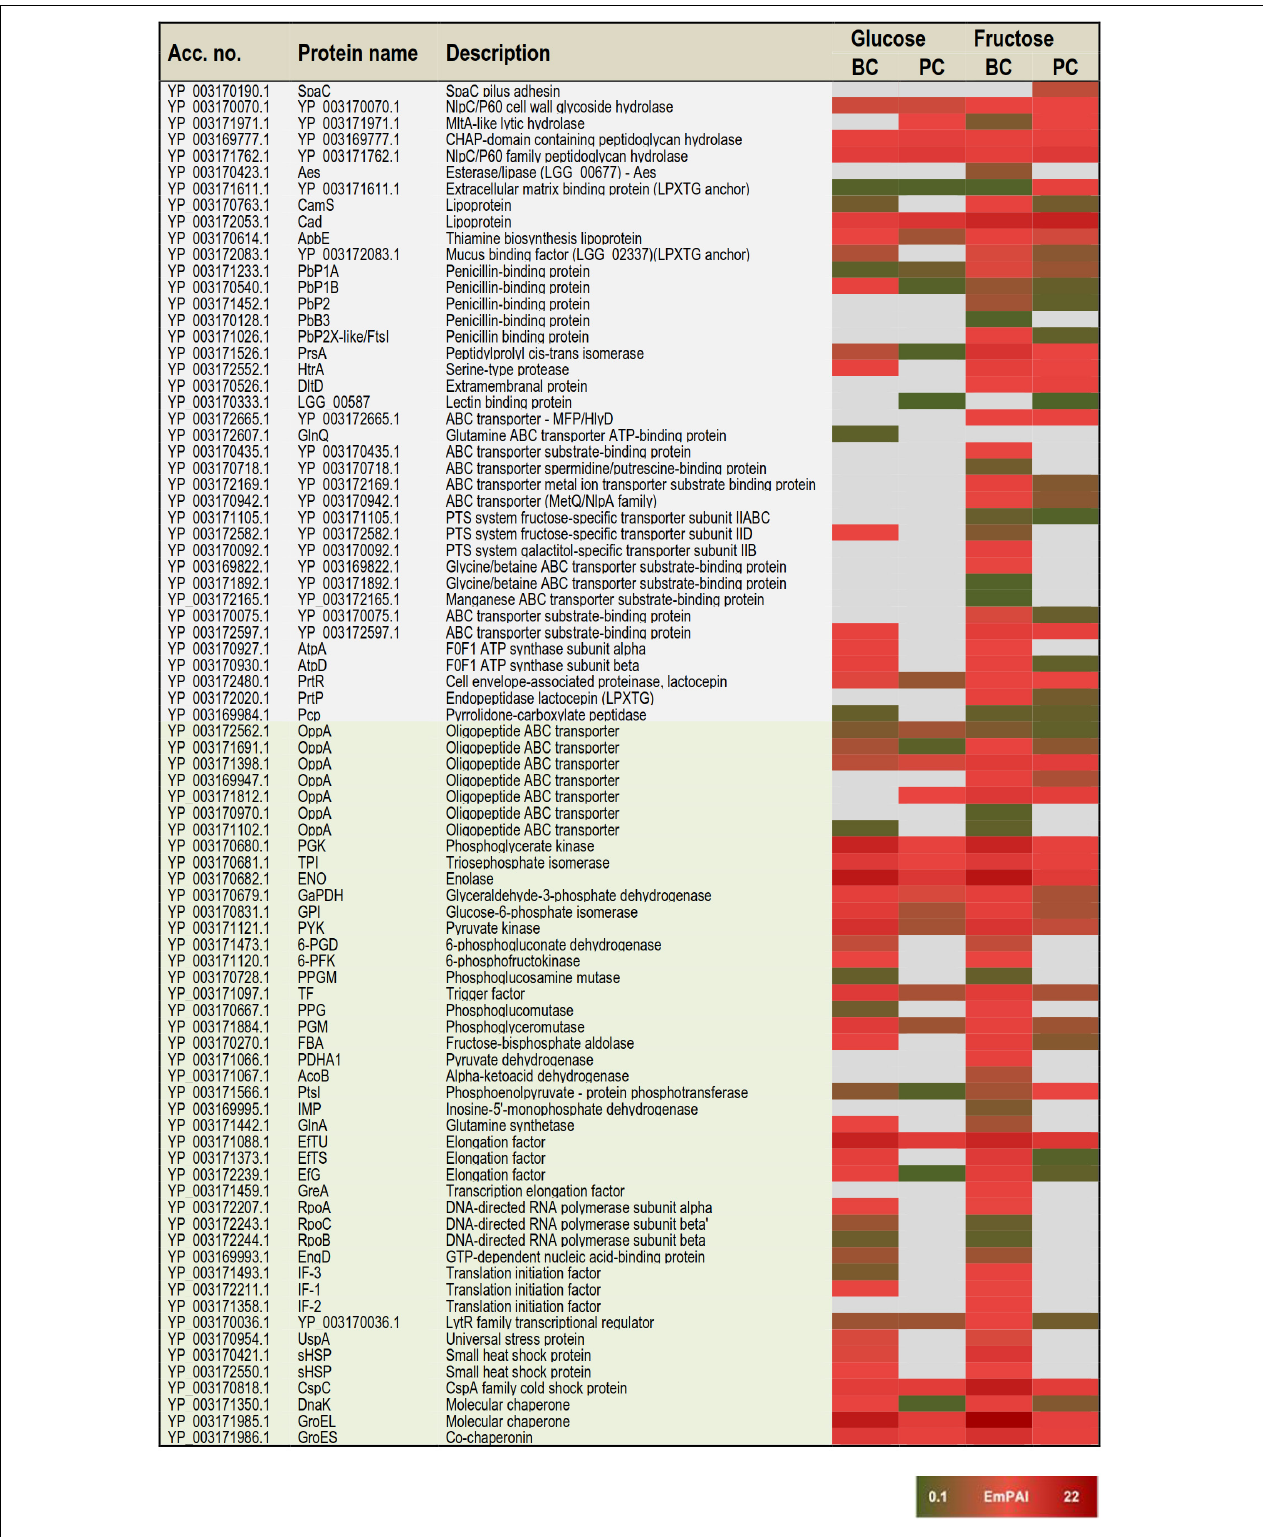
FIGURE 3 | A heat map comparing the most distinctive protein abundance changes (estimated by the emPAI values) among the classical surface proteins anchored to cell-wall/-membrane via motifs or domains (names shaded in gray) and among known and/or adhesive moonlighters (names shaded in light green). Red and green refer to higher and lower protein abundances,